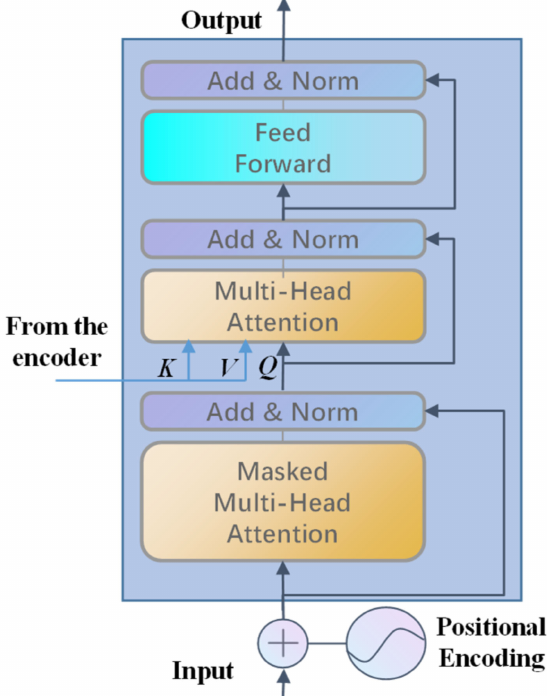
Figure 6. Structure of a decoder.